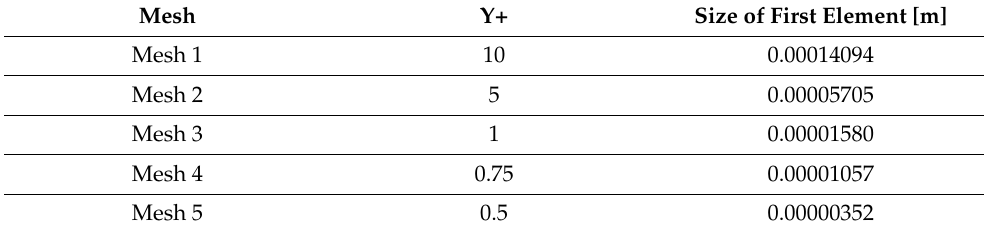
Table 3. Parameterization of the mesh of the blades